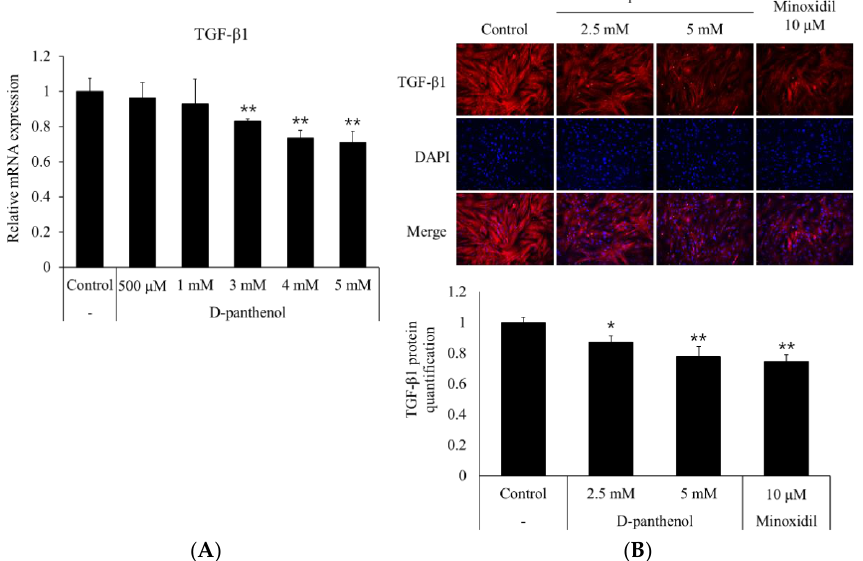
Figure 4. D-panthenol reduced TGF- β 1 expression in cultured hDPCs. Treatment of D-panthenol for 24 h decreased the ( A ) mRNA and ( B ) protein expressions of TGF- β 1 in cultured hDPCs ( × 200 mag- nification). * p < 0.05, ** p < 0.01 versus control group. Data are expressed as mean ±